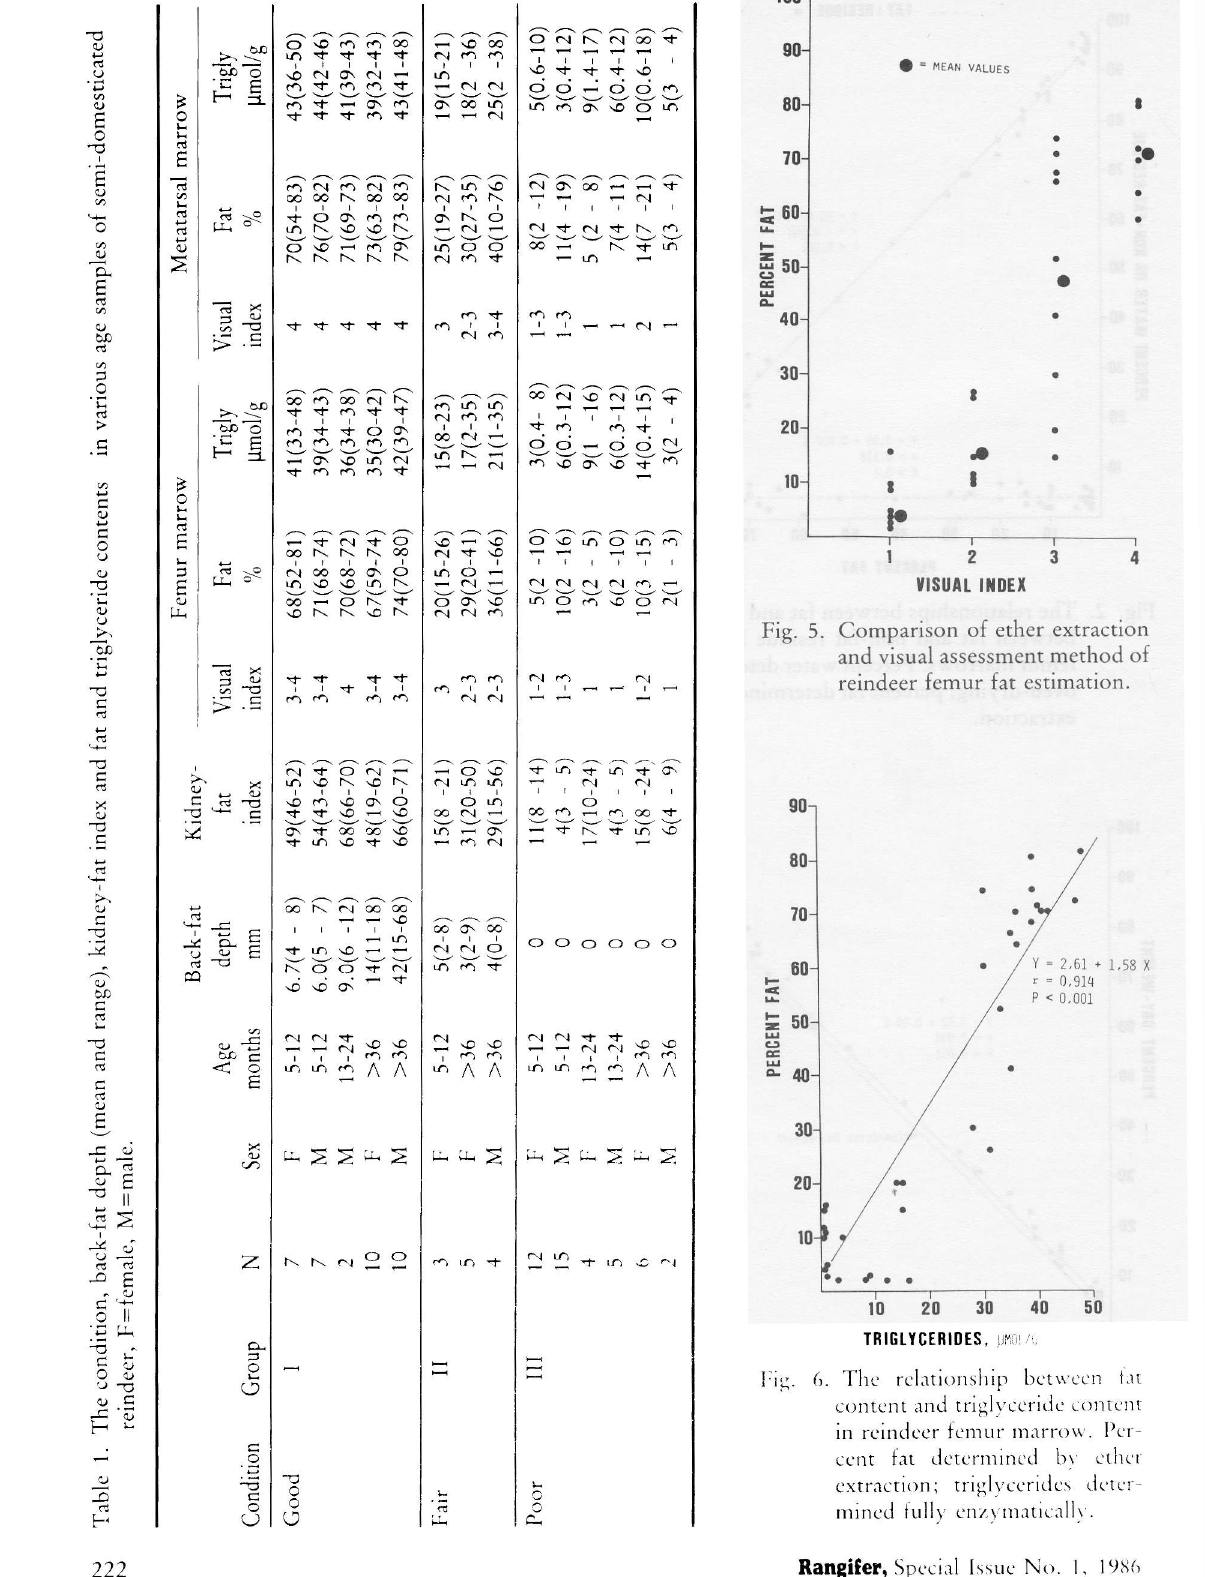
6. The relationship between tat content and triglyceride content in reindeer femur marrow. Per cent fat determined bv ether extraction; triglycerides deter mined fully enzymatic